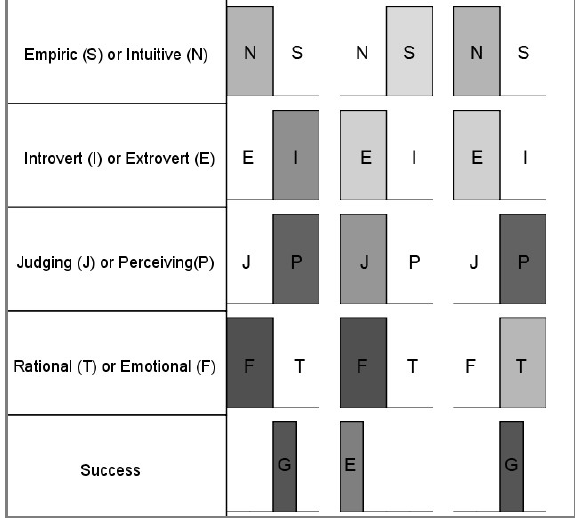
Fig. 3. Student profiles for course on Mathematics Figures 3 and 4 show different groups of students on different courses. Each row represents different cognitive properties (described in detail in section 3.1). Each column represents one profile, which is a group (cluster) of students with similar cognitive